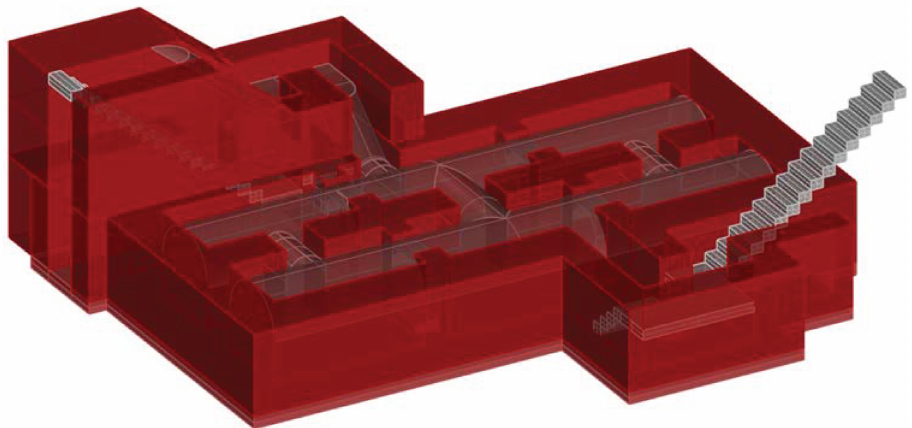
Figure 3. Image of the volumetry of the refuge of Plaza Balmis where the two entrances are shown. The right corresponds to that of the streets Limones and Cid, currently walled and the left corresponds to the only entrance available. The vaulted roofs are shown in a lowered semicircular arch. In the upper part there is a large concrete layer of up to 1.5 m, this side being the most